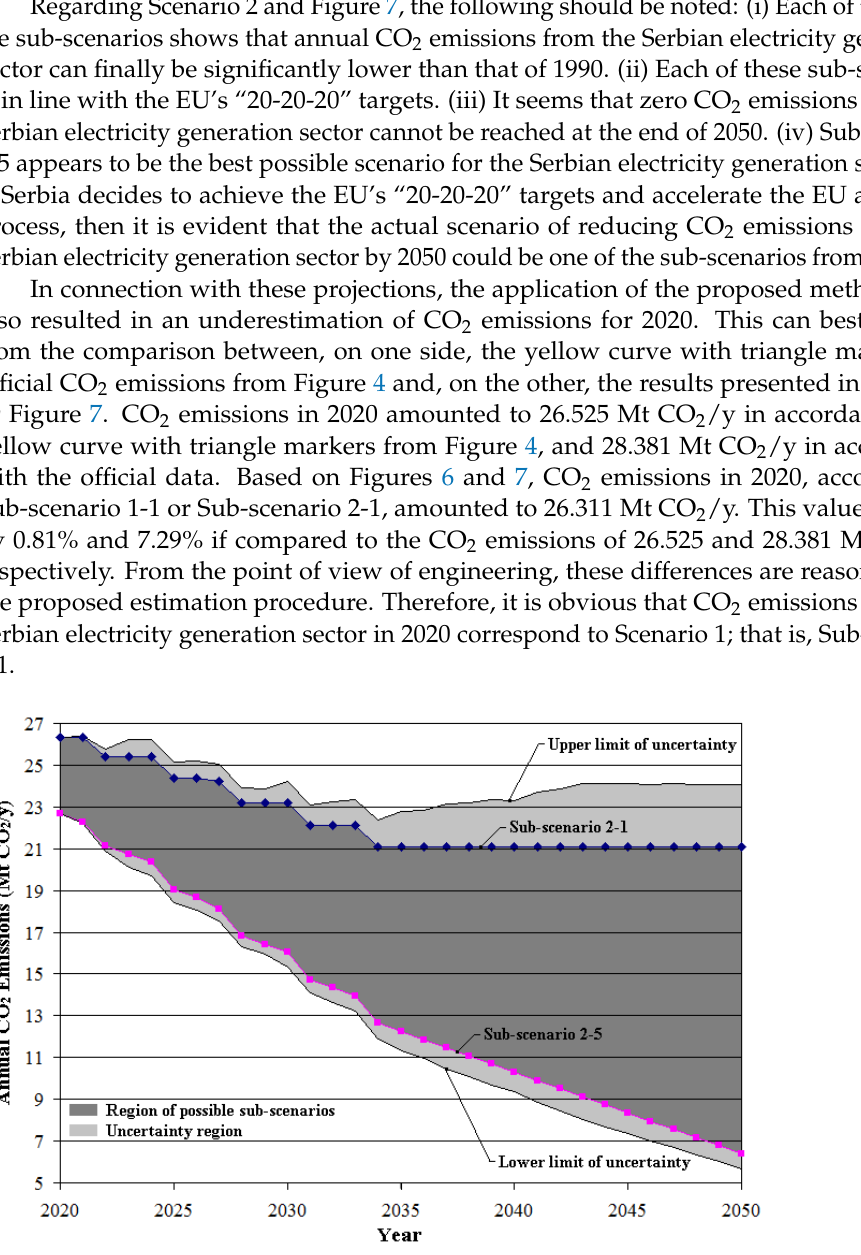
Figure 7. Region of possible sub-scenarios for annual CO 2 emissions from the Serbian electricity generation sector together with the corresponding upper and lower limits of uncertainty for the period 2020–2050, taking into account the EU’s “20-20-20” targets, that is, Scenario 2.